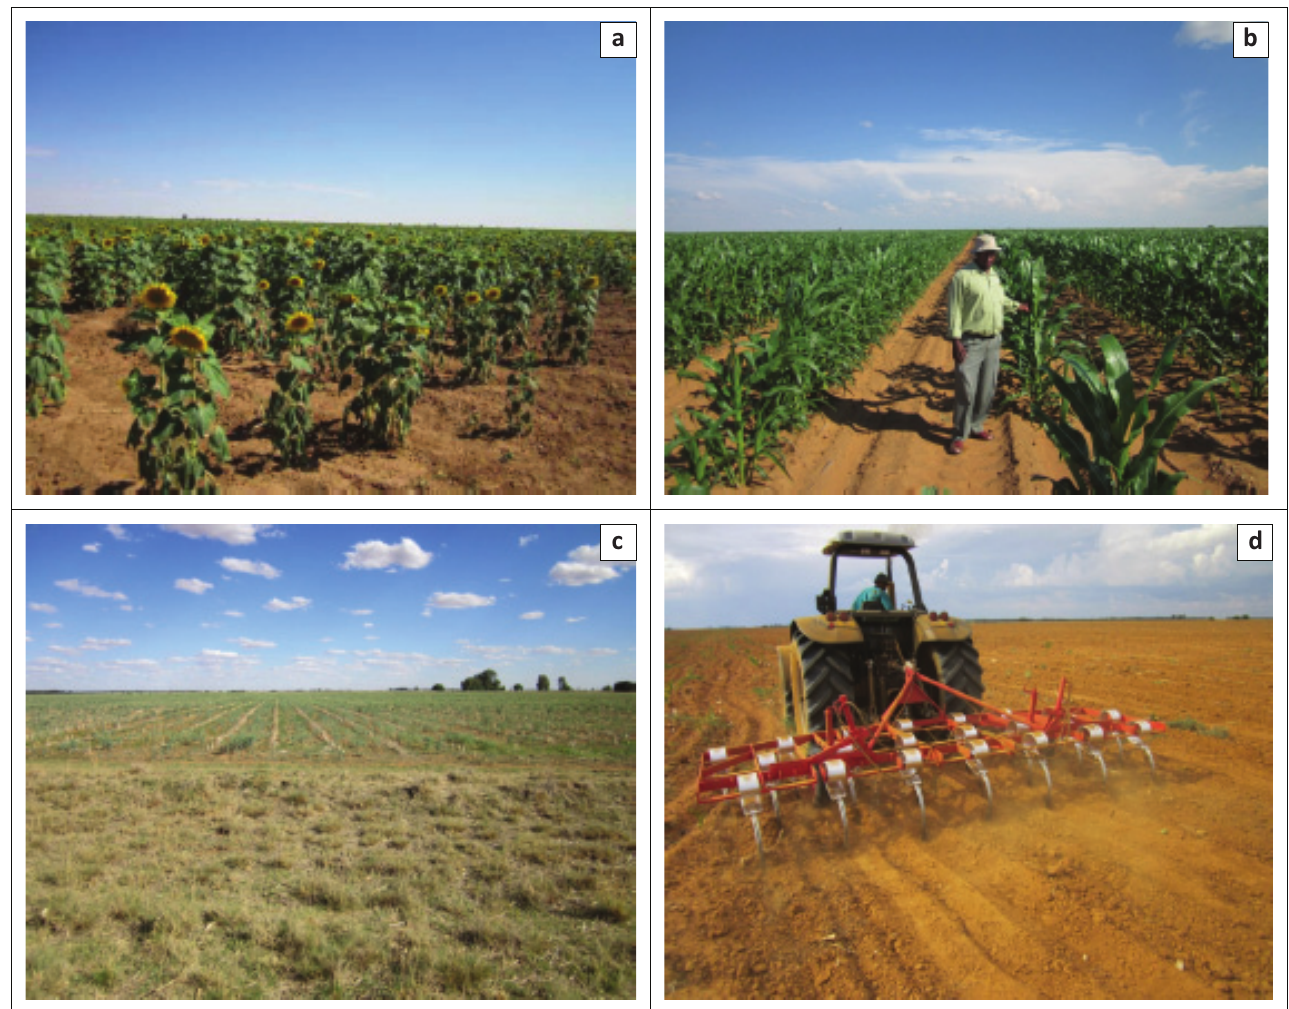
FIGURE 2: Photographs taken in 2013 in the Mooifontein farming region. (a) Sunflower field at Weltevrede, March 2013, (b) Maize growing in February 2013, Weltevrede, (c) Deelpan farmlands: Weed control is a widespread problem and (d) Vibroflexing is a step in the right